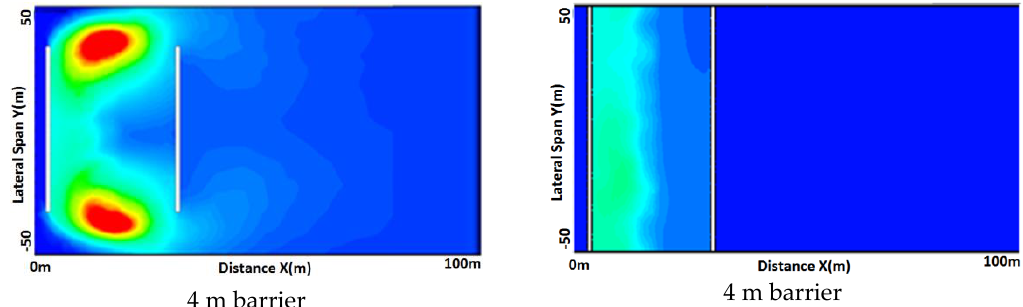
Figure 12. CO 2 concentration for with and without side edge effect cases in X–Y plane at ground level.